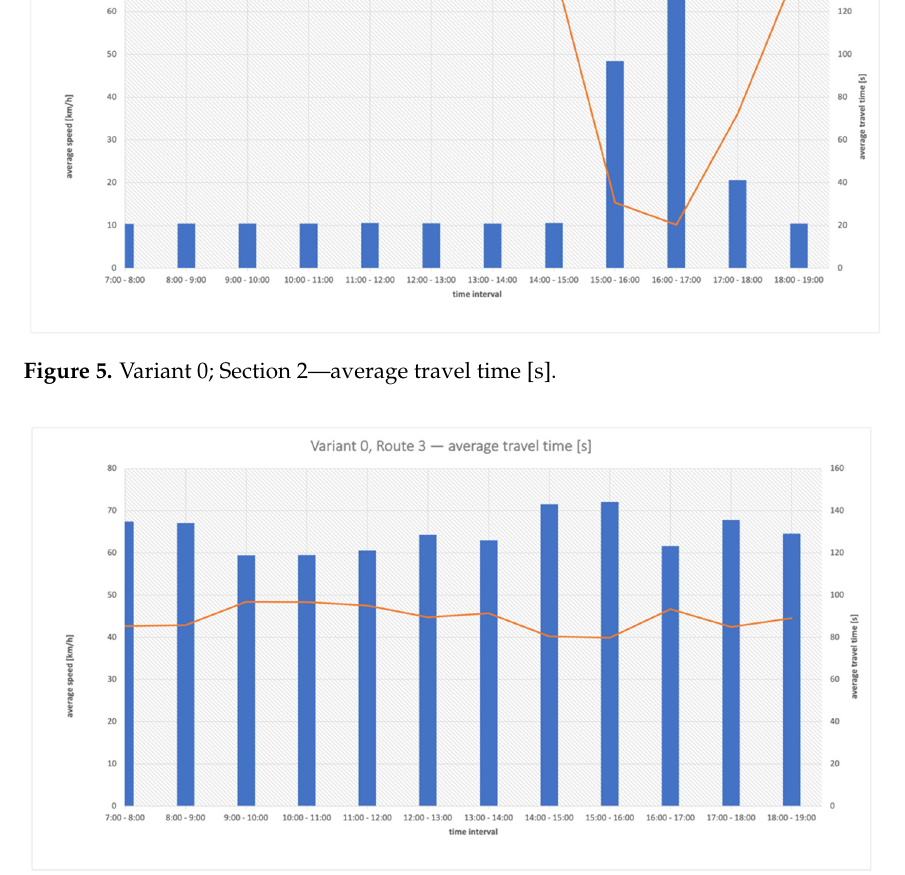
Figure 6. Variant 0; Section 3—average travel time [s].